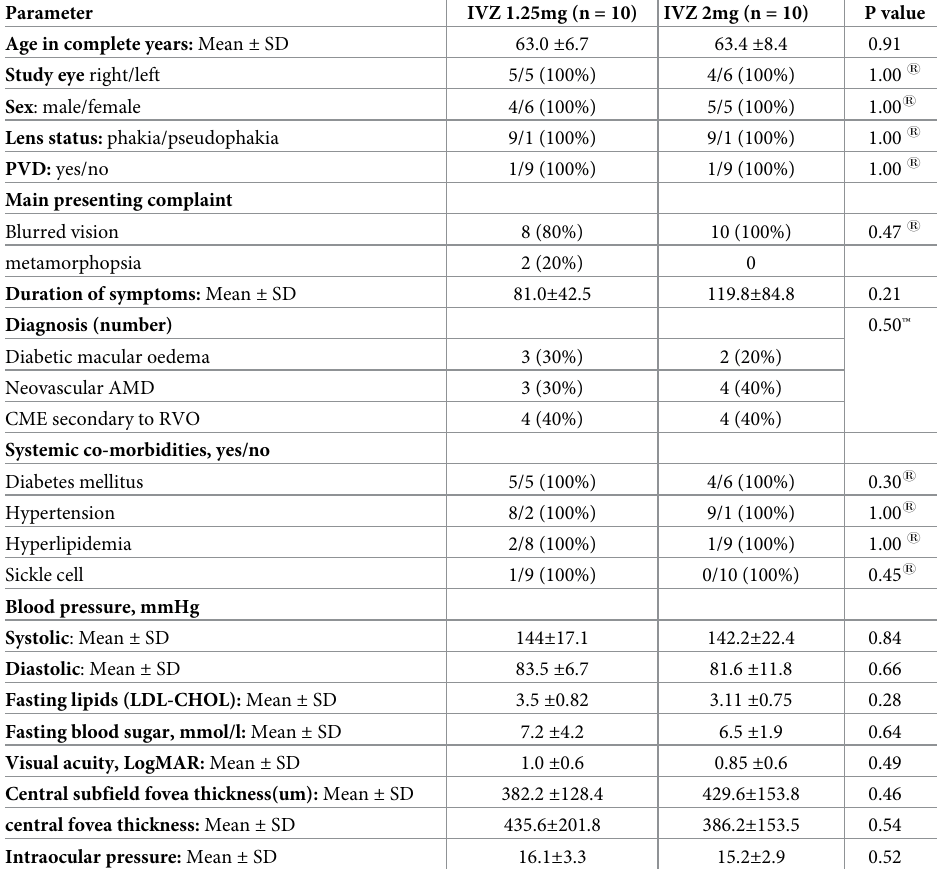
Table 1. Baseline characteristics of 20 eyes on treatment with intravitreal ziv-aflibercept. Parameter